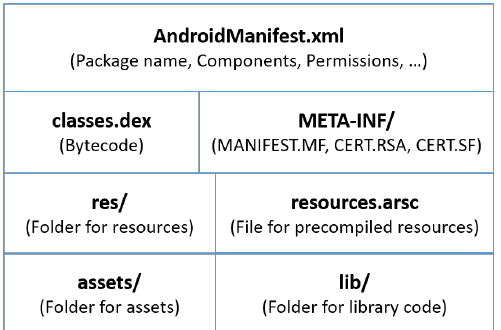
Figure 1. Structure of APK